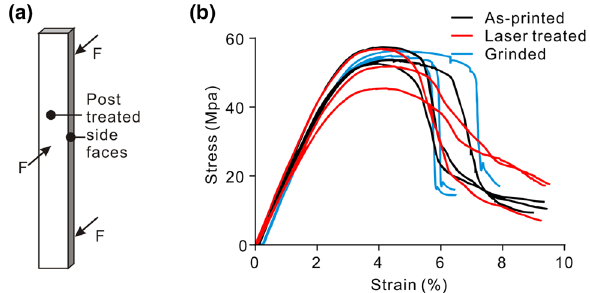
Fig. 5 Flexure test. a Schematic of flexure test; b Stress–strain curves of ME specimens with different post processing. There is no statistically significant difference, but grinded samples exhibited brittle fracture